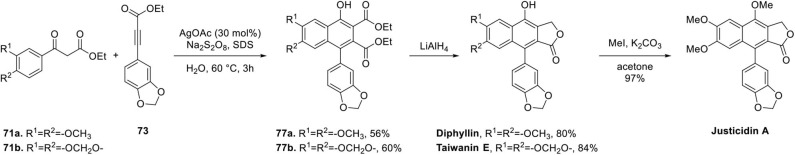
Synthesis of arylnaphthalene lignan lactone by Ag-catalyzed cyclization.